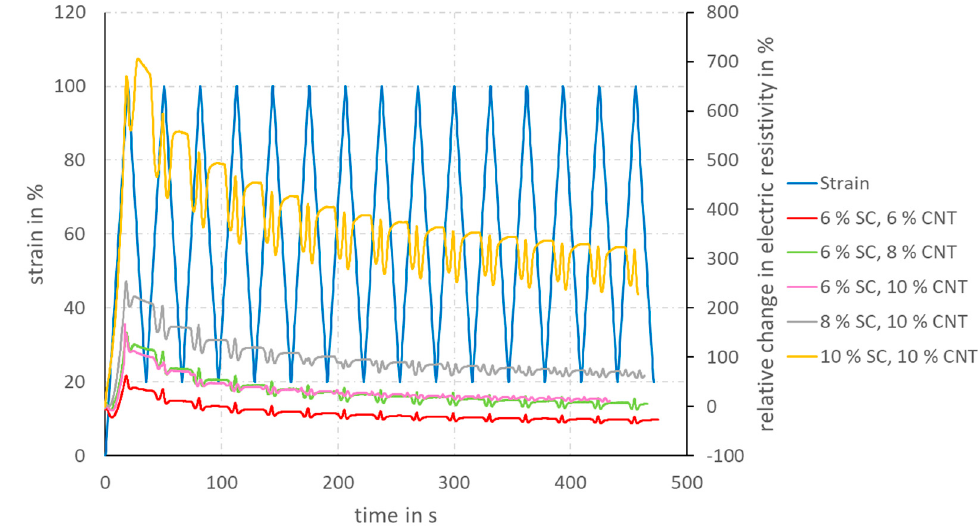
Figure 7. Cyclic-strain diagram of coated TPU yarns, showing the relative change in electric resistivity, depending on the strain; the light blue plot shows the mechanical strain, depending on time, whereas the other plots describe the electrical resistivity, depending on time.